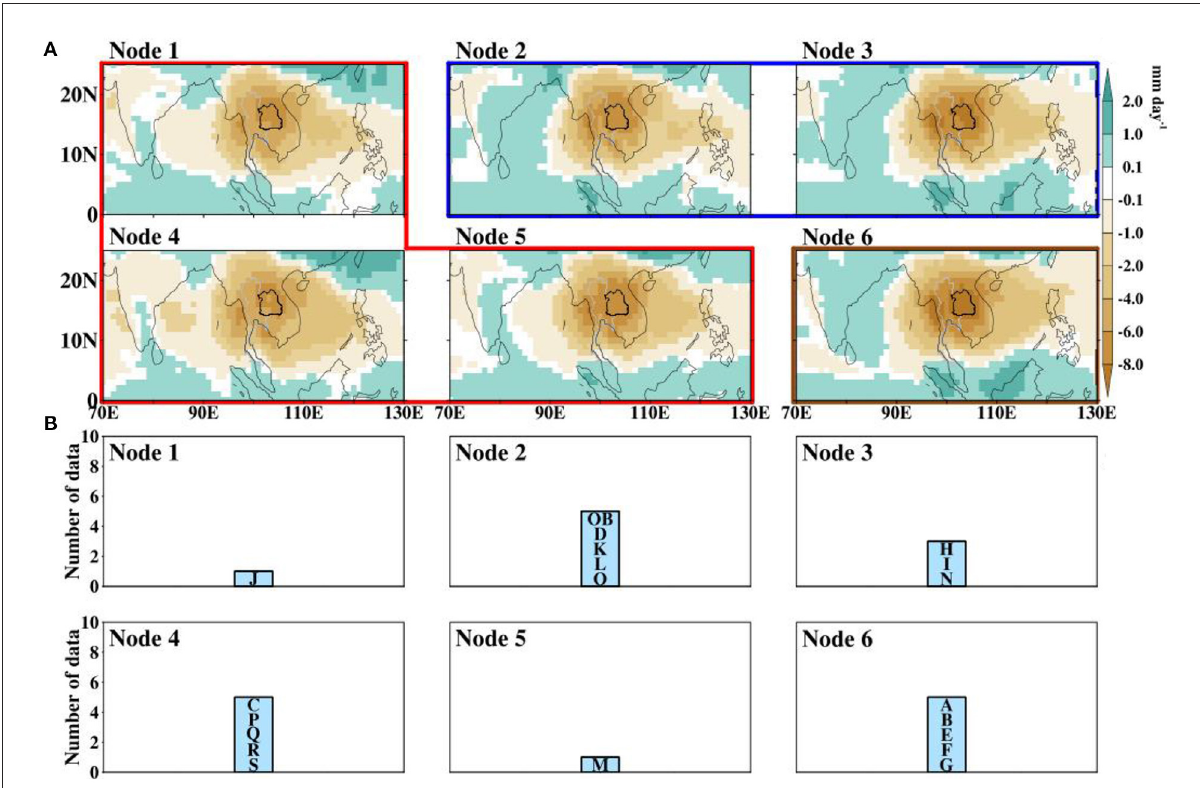
FIGURE3 SOMS maps of Figure 2 for dry spells composite anomalies of (A) observed and (B–T) simulated rainfall. The top panels (A) show the classification of the rainfall patterns while the bottom panels (B) show the number of data that contribute to the rainfall patterns in the nodes in the top panels. The alphabet tag in the bar represents the code of the models that make up the bar (Table 1).